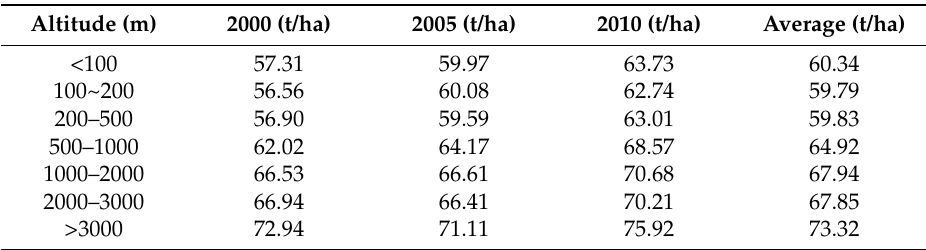
Figure 8. Relationship between altitude and carbon density. Table 3. Carbon densities at different